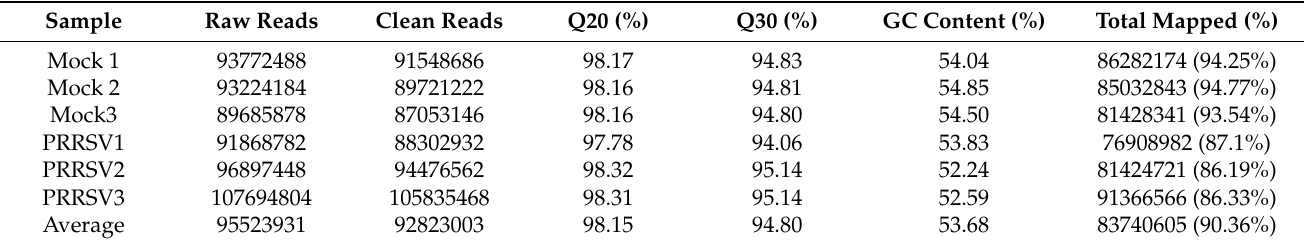
Table 1. Overview of the RNA sequencing